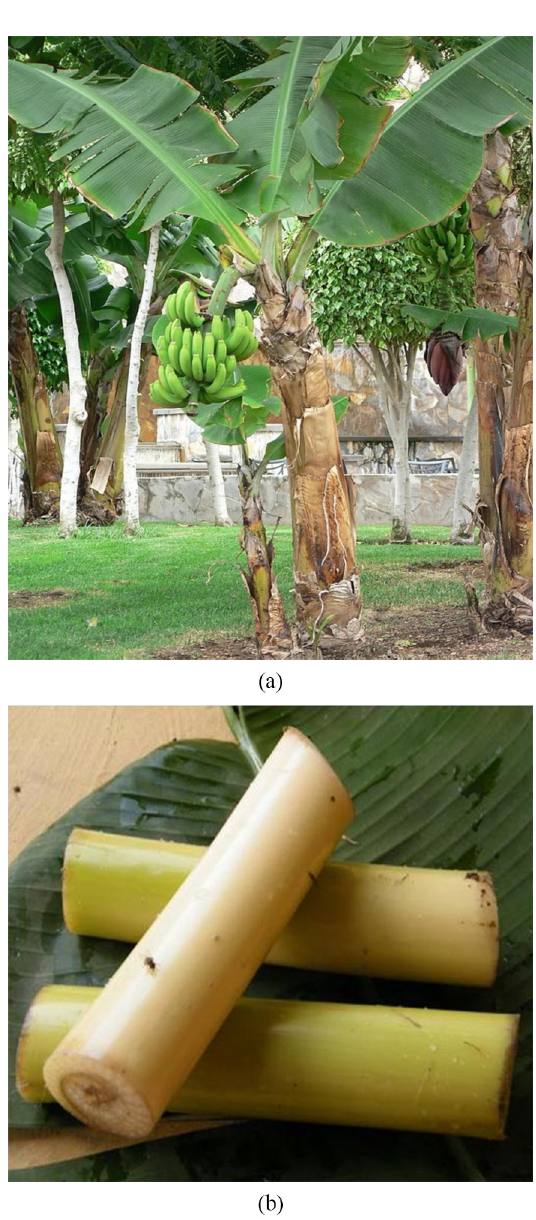
Figure 1. Banana plant (a) and stem cut after harvest (b).